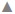
Parasite loads in mammalian cells infected with either wild type, Δtcpot1, or Δtcpot1[pTcPOT1] “add-back” parasites.Vero cells were infected with (A) wild type, (B) Δtcpot1, or (C) Δtcpot1[pTcPOT1] metacyclic trypomastigotes at a ratio of five parasites per cell and DAPI-stained amastigotes enumerated as indicated in the Experimental procedures section. Each color represents data from three independent experiments for the wild type and Δtcpot1 cell lines and is indicated as n1 (black), n2 (orange), or n3 (blue), and data from two independent experiments for the “add-back.” Within each experiment amastigotes enumeration was performed in duplicate. (D) Demonstration that putrescine transport capability has been conferred by ectopic expression of TcPOT1 in the Δtcpot1[pTcPOT1] “add-back” line. Putrescine transport was measured as described for Fig 2 in wild type (■), Δtcpot1 (grey dot), and Δtcpot1[pTcPOT1::GFP] () cells, and the data presented are those of three replicates. Direct fluorescence microscopy (x63 magnification) (E) displays expression of TcPOT1.1::GFP in Vero cells infected with T. cruzi amastigotes. Shown are a phase contrast image (1), a merge of GFP and DAPI images (2), GFP fluorescence (3), and DAPI-stained parasites (4).